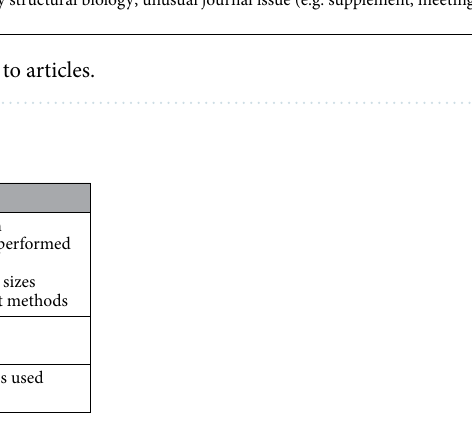
Table 4. Description of items used to quantify the insufficiencies in reporting in articles.